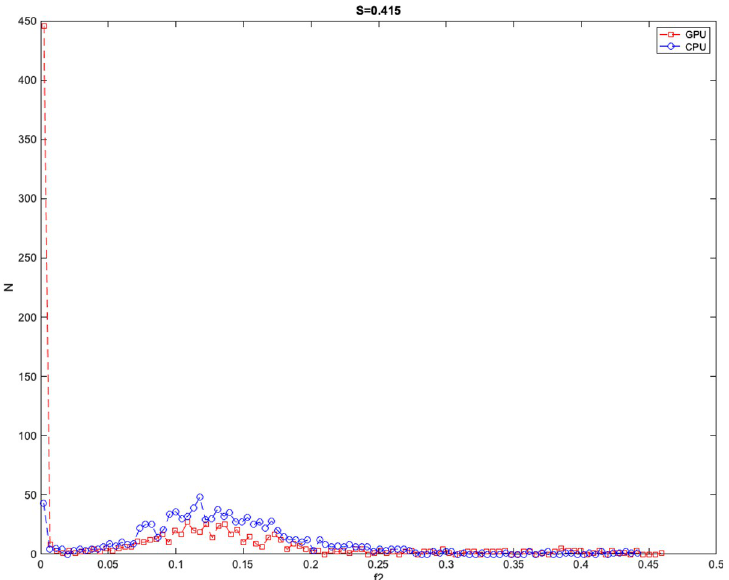
Fig 5. Example distribution shape difference in f 2 . Example distribution shape differences in f 2 . Red squares with dotted line denotes GPU samples and blue circles with dotted line denotes CPU samples.